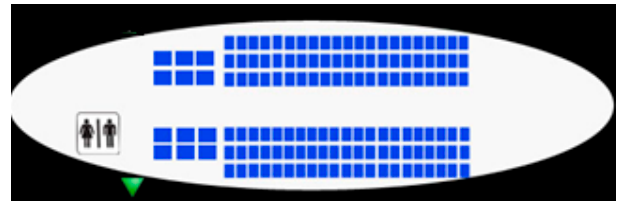
Figure 1. System overview.